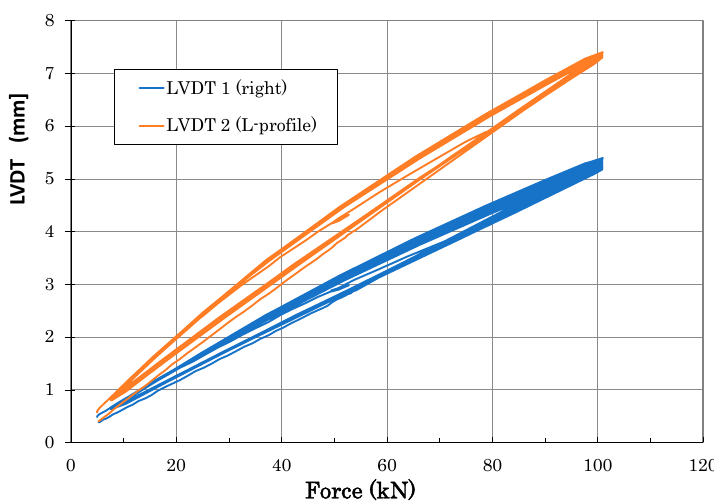
Figure 14. Example of typical LVDT curves measured during fatigue tests (measurement points are defined in Figure 9).